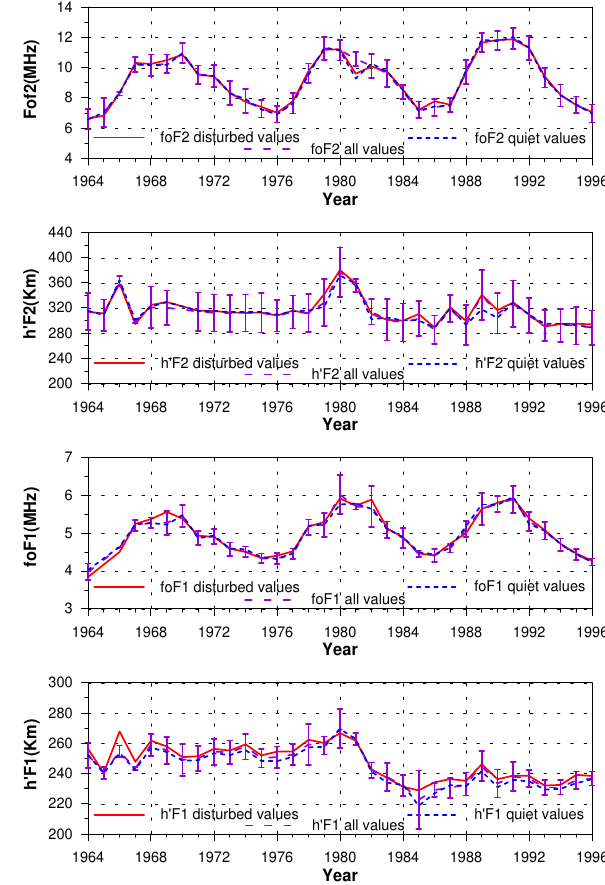
Fig. 3. Annual variation of fo F2 , h 0 F2 , fo F1 and h 0 F1 (from the top to the bottom), during solar cycles 20, 21 and 22. The red curves correspond to the magnetic disturbed days and the blue curves to the magnetic quiet days. The violet curves concern all the